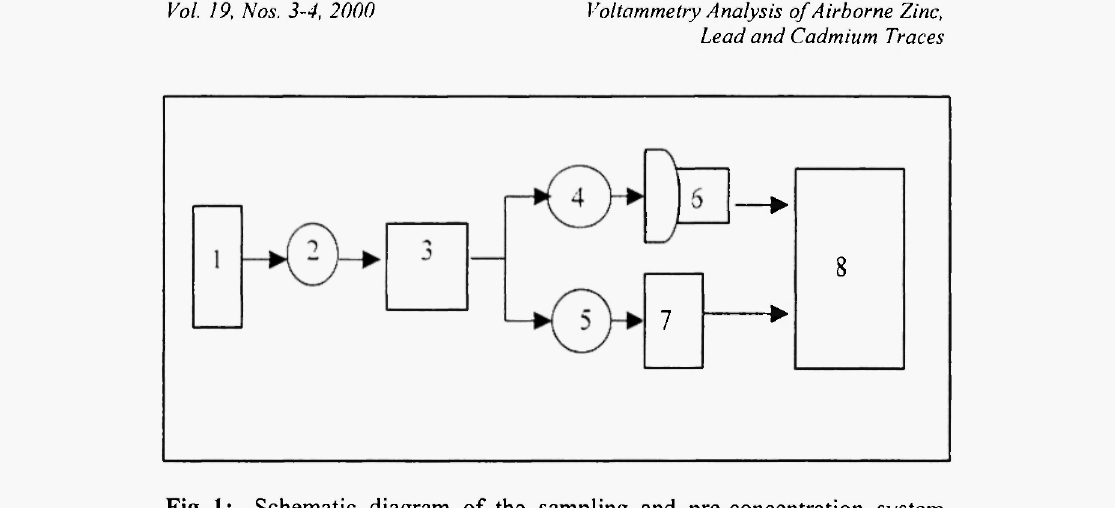
Fig. 1: Schematic diagram of the sampling and pre-concentration system equipped with electroanalytical detector. 1- Contaminant mixture, 3 - Staplex Hi-Volume sampler, 2, 4, 5 - flow meters, 6 - filter holder with glassy fiber filter, 7 - Venturi-based sampler, 8 - polarographic